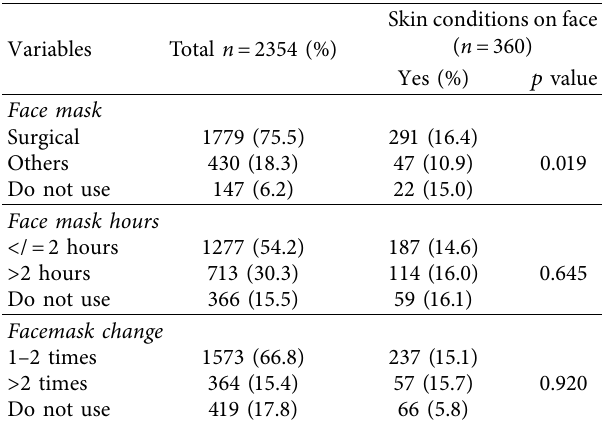
Table 3: Factors leading to skin conditions on the face during the COVID-19 pandemic ( n � 821). Variables Total n � 2354